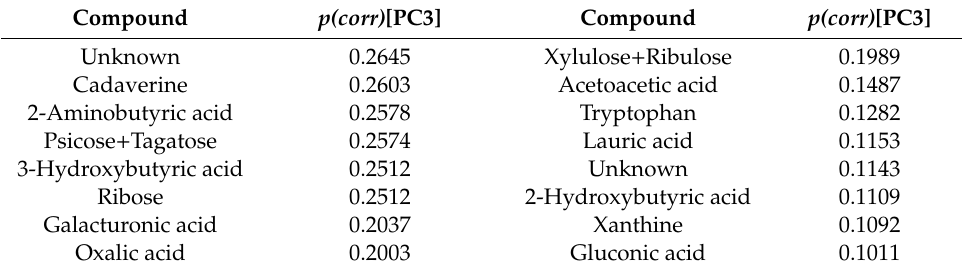
Table 4. Characteristic hydrophilic low-molecular-weight compounds in quinoa-based soy-sauce-like seasoning on